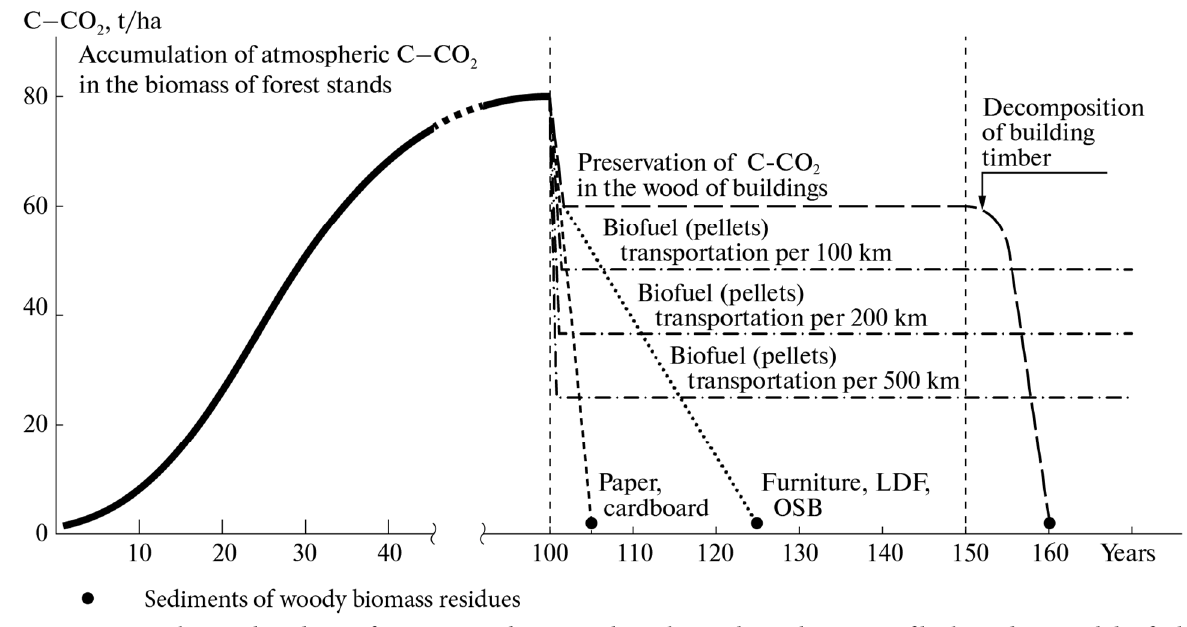
Figure 1. Scheme of a three-stage method for calculating the balance of C-CO 2 in the atmosphere when growing forests and using wood .